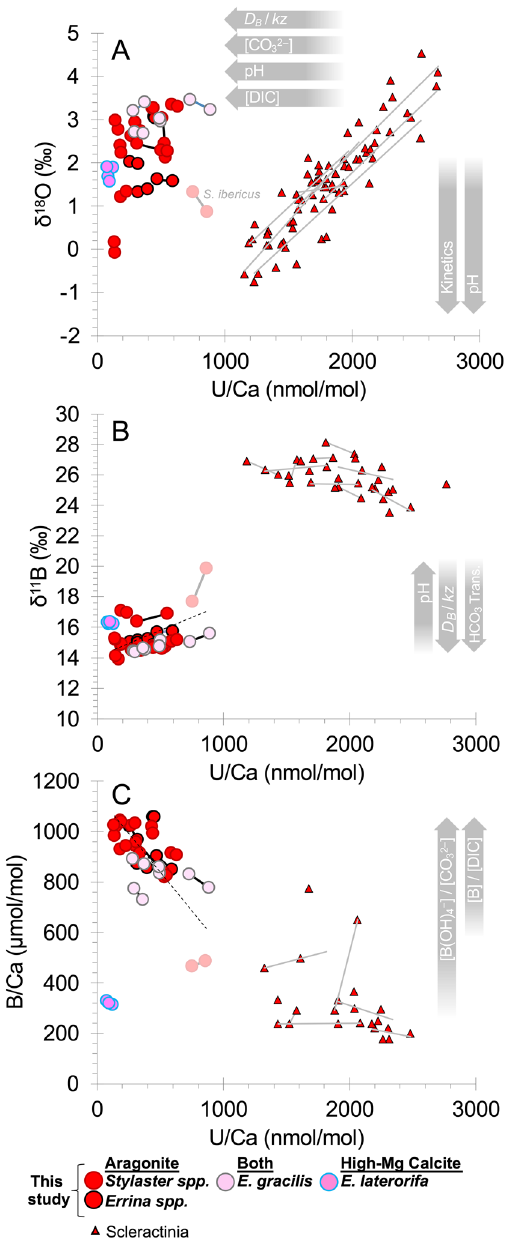
Figure 5. Coral U/Ca against ( A ) δ 18 O and ( B ) δ 11 B ( C ) B/Ca. Stylasterid U/Ca, B/Ca, and δ 11 B data are from this study, paired with δ 18 O measurements in the same specimens 28 . Scleractinian D. dianthus data are from micro-sampled specimens by Chen et al. 53 and Stewart et al. 47 . Individual analyses from the same specimens are connected by solid trend lines (2 analyses or more). Dashed trendlines show the covariance between all aragonitic stylasterid measurements (p <